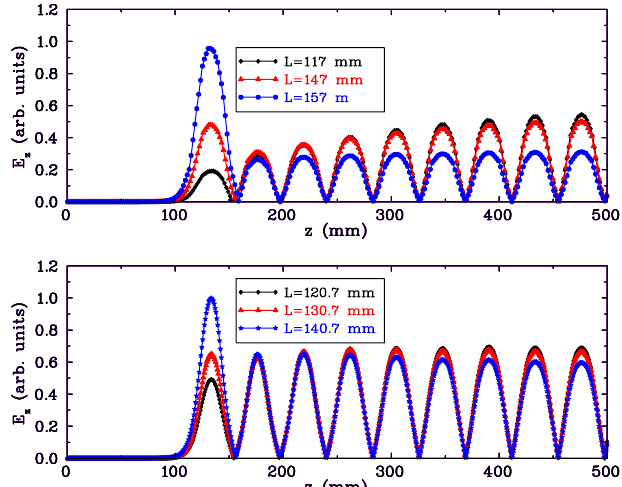
FIG. 5. (Color) Top: Simulated electric gap field distribution for different end-cell lengths and constant g=L ratio of 0.5. Bottom: Simulated electric gap field distribution for different end-cell lengths and variable g=L ratios.